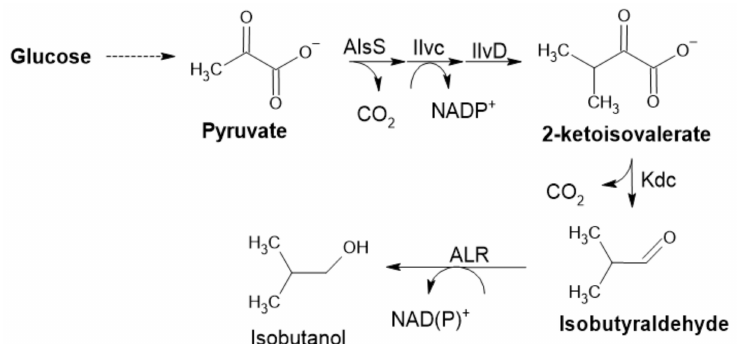
Figure 8. Isobutyraldehyde pathway in E. coli , with the aldehyde-forming enzyme 2-KID (Adapted with permission from ref. [7]. Copyright 2014